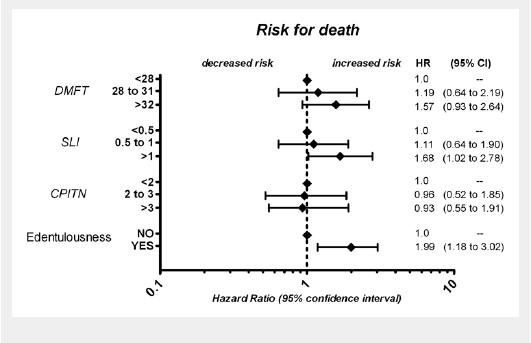
Adjusted risk for overall mortality according to tertiles of DMFT, SLI, CPITN and edentulousness